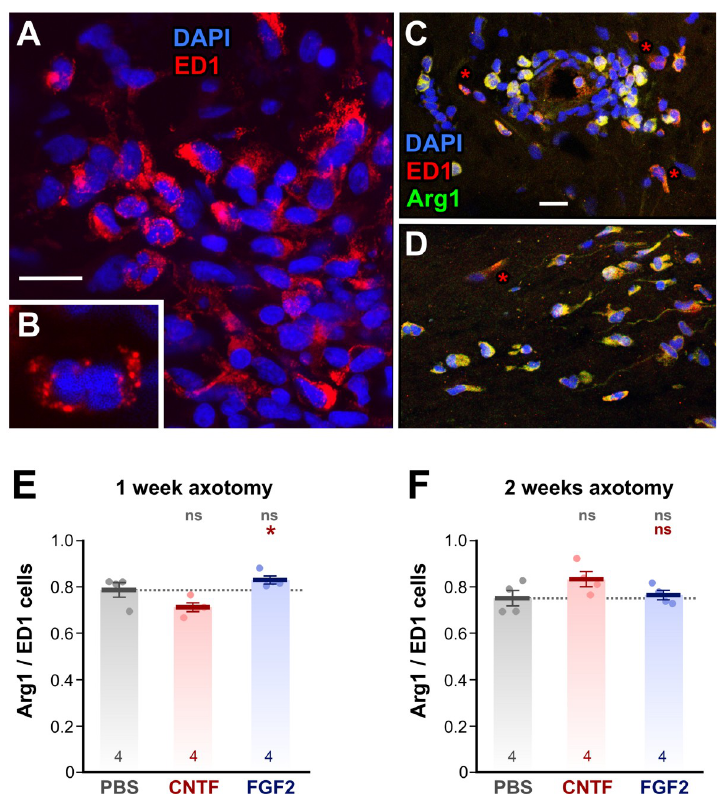
Fig 3. Immunostaining of macrophage subtypes. (A—D) Confocal fluorescence micrographs of immunostained frozen sections of optic nerve 1 week after axotomy. (B) High magnification single slice of a macrophage with an irregular nucleus, clearly showing ED1-LI-stained lysosomes. (C) Double staining of peripherally-located macrophages with ED1 and Arg1. Only a few cells have predominantly ED1-LI with little Arg1-LI (asterisks). (D) Double staining of centrally-located macrophages with ED1 and Arg1. Only a few cells have predominantly ED1-LI (asterisks). (E and F). Combined scatterplots and barcharts of Arg1-LI/ED1-LI ratio showing mean ± SEM. Asterisks or “ns” above each column indicate the significance when compared to PBS (row 1, gray) or CNTF (row 2, red) with ANOVA and post- hoc Tukey tests. At 1 w (E) and 2 w (F) after nerve crush there is no change in the Arg1-LI/ED1-LI proportion with CNTF and FGF-2 treatment, compared to PBS-treated controls. Scale bar: 20 μ m in A, C, D; 10 μ m in B.